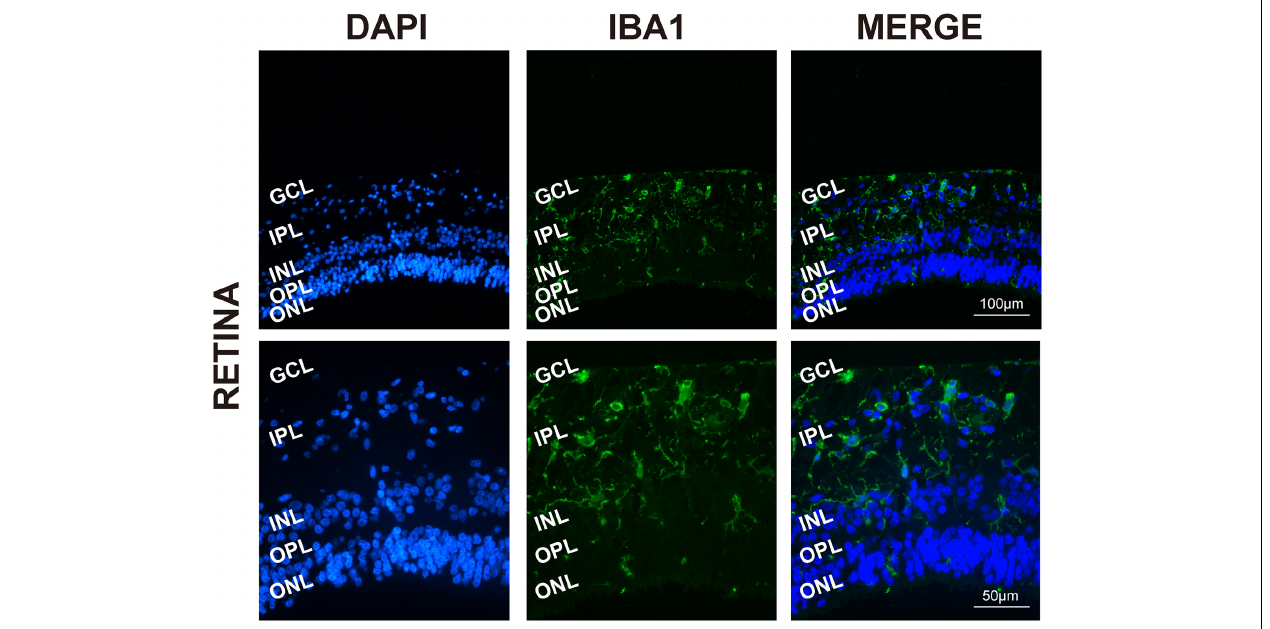
FIGURE 1 | Retinal microglia located in the GCL and around the vessels. Representative immunofluorescence photomicrographs of retinal microglia marker Iba1 to label the location of retinas (GCL, ganglion cell layer; IPL, inner plexiform layer; INL, inner nuclear; ONL, outer nuclear layer). Scale bar: 100 µ